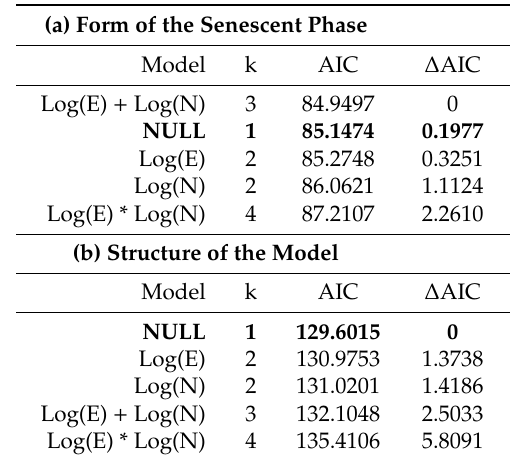
Table 1. AIC (Akaike Information criterion) rankings for the multinomial logistic models associated with ( a ) the form of the mortality curve during the senescent phase and ( b ) the structure of the mortality model. The model selected is presented in bold. ‘*’ means interactive e ff ect between the two factors